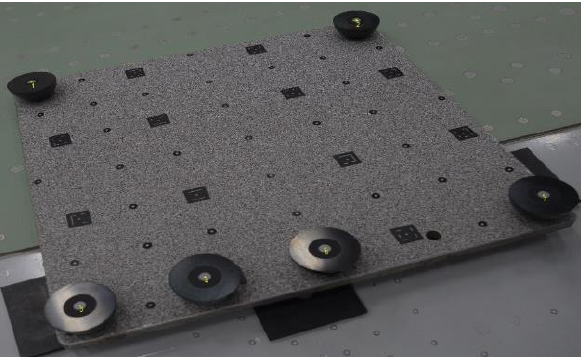
Figure 4. Aluminium reference plate in dome characterisation location.